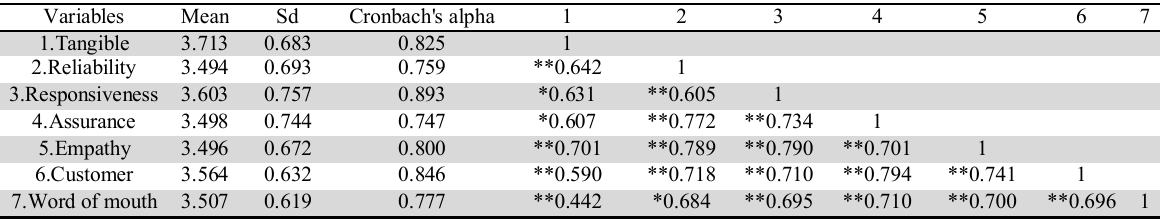
Correlation coefficients of variables